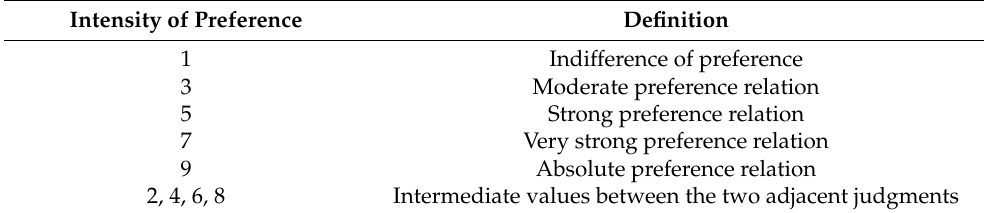
Table 7. Relative preference scale for the alternatives.